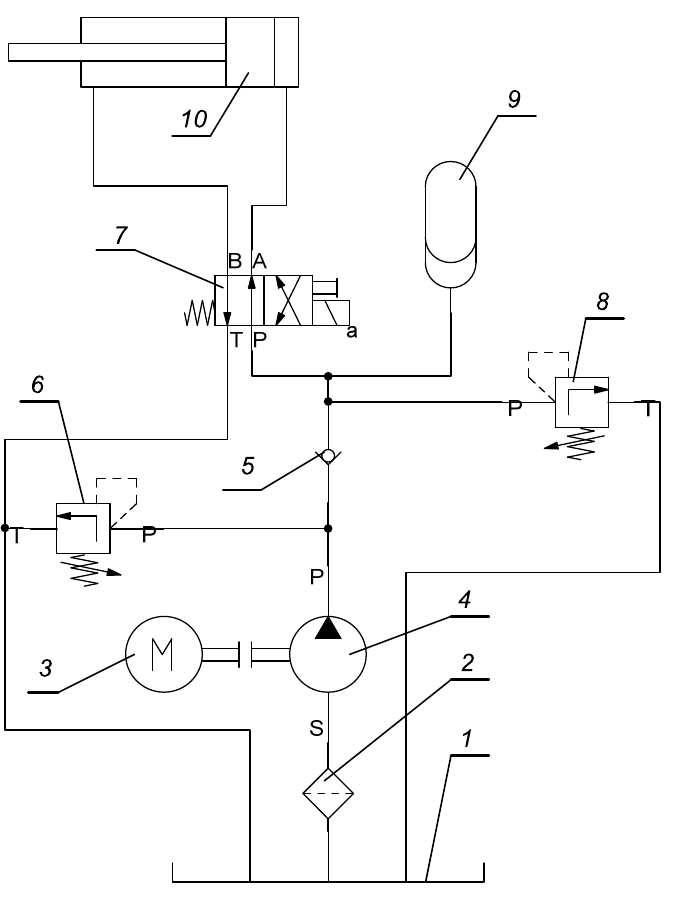
Figure 2. Hydraulic circuit: 1—reservoir; 2—filter; 3—motor; 4—pump; 5—check valve; 6 and 8—relief valve; 7—four way, two position directional control valve; 9—accumulator; 10—hydraulic